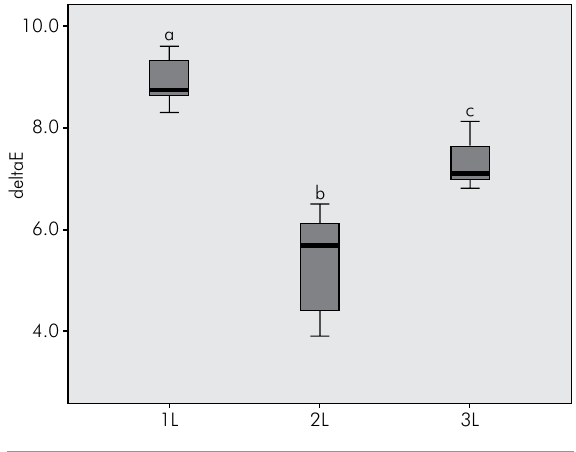
Figure 1. Color difference ( Δ E) between a shade A3 resin denture tooth and layered resin overlays. Δ E value of the three groups was statistically significant ( p < 0.05). 1L = Z350 A3;